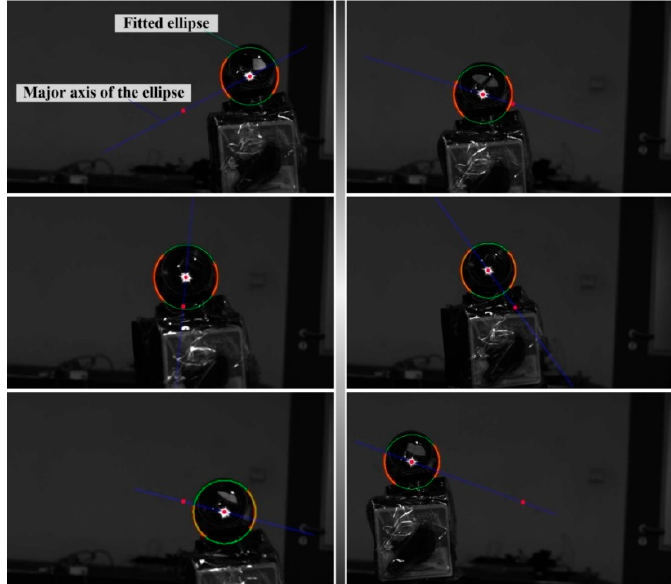
Figure 3. Six examples of ellipse detection and fitting results for the left projection images.